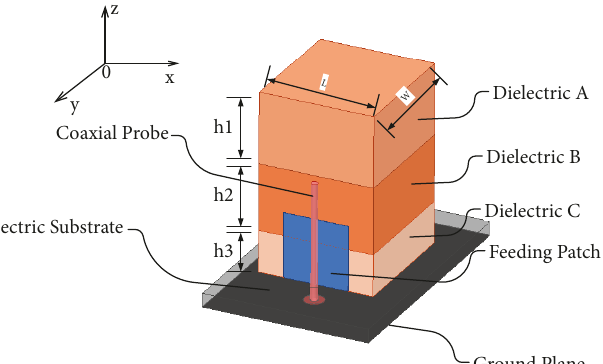
Figure 1: Configuration of the DRA element.